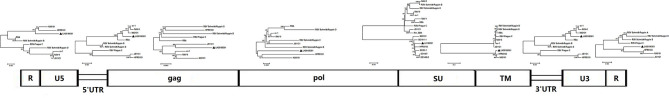
Segmental sequence comparison between the isolate LH20180301 and other ALVs. The genome sequences were divided by functional areas and multiple sequence alignment was carried out for each segmental sequence. Bottom box: genome structure of the isolate LH20180301. Phylogenetic tree: evolutionary relationships of each fragment inferred using the Neighbor-Joining method with 1000 bootstrap replicates (MEGA 6). Bar: substitutions per nucleotide position.